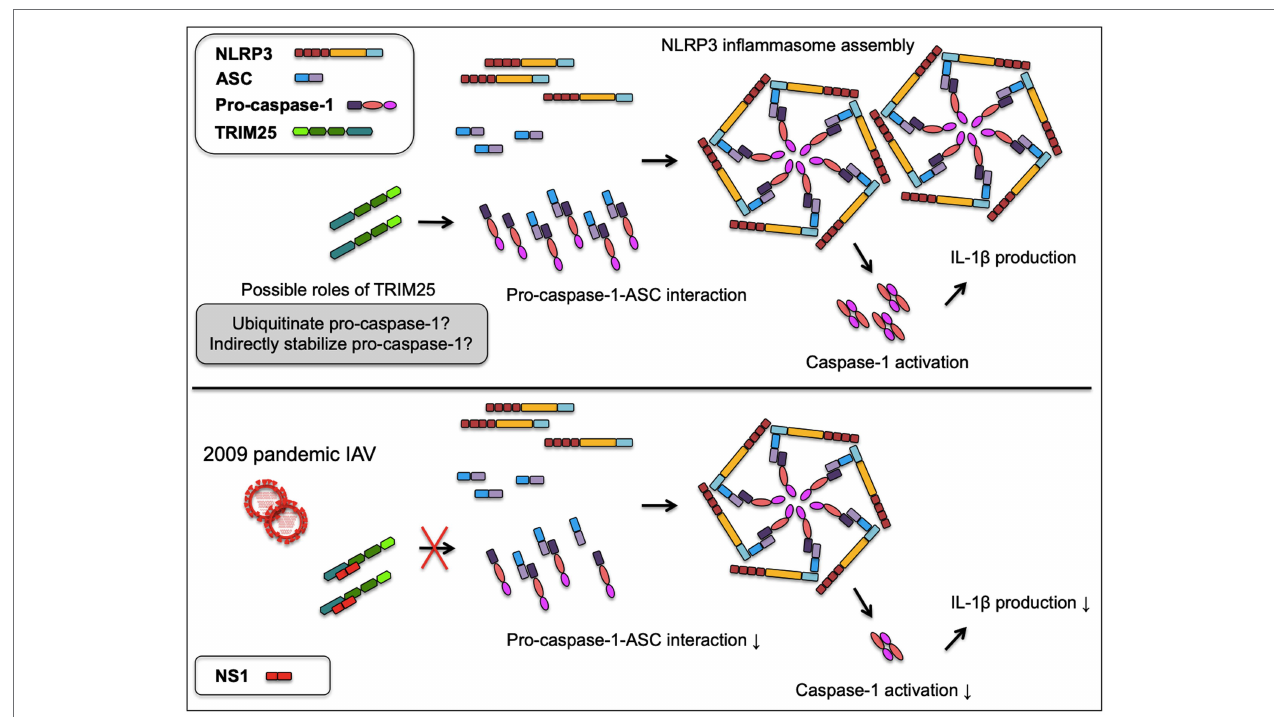
FIGURE 5 | A proposed model of NS1 targeted TRIM25-mediated NLRP3 inflammasome activation. TRIM25 promotes the interaction between pro-caspase-1 and ASC by acting on the N-terminal CARD of pro-caspase-1. TRIM25 may possibly ubiquitinate the pro-caspase-1 CARD or indirectly contribute to the stabilization of pro-caspase-1, while the mechanisms are yet to be determined. Increased pro-caspase-1-ASC interaction leads to the enhanced assembly of NLRP3 inflammasome and caspase-1 activation required for IL-1 β production. Upon infection with 2009 pandemic IAV, the NS1 C-terminus binds TRIM25 to disrupt the pro-caspase-1-ASC interaction, resulting in the decreased caspase-1 activity and IL-1 β